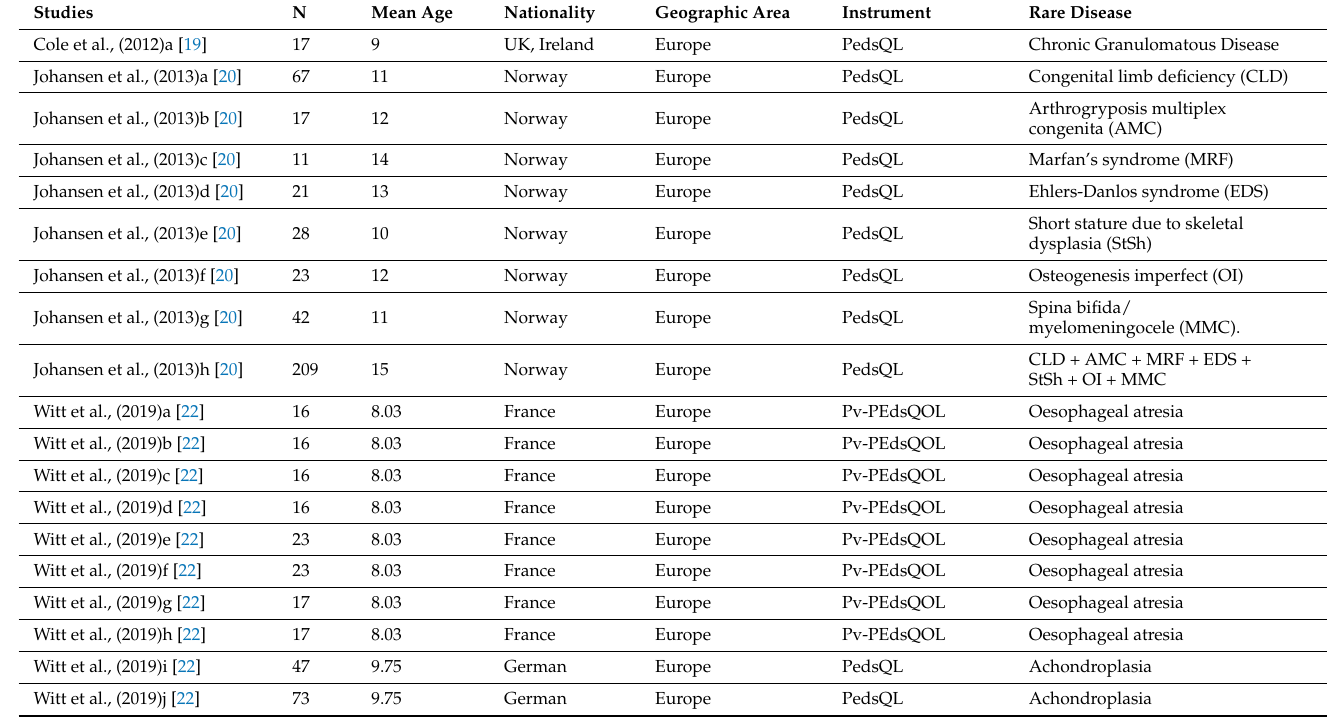
Table 6. Sociodemographic results of the sample in the educational